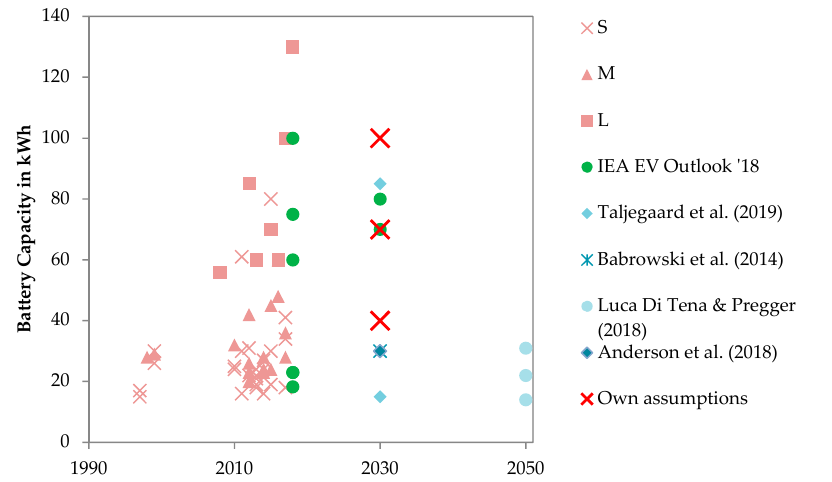
Figure A2. Historic development, prospective values from literature and own assumptions of BEV battery capacity values in kWh. Historic values are given in light red and differentiated between small (S), medium (M) and large (L) BEV models. Historic values are not weighted by sales or stocks. Ranges given in the IEA EV Outlook for 2018 as well as average fleet ranges for 2030 are given in green. Literature projections for 2030 and 2050 are given in light blue as indications. Own assumptions for the REMix model runs 0 and 1 are given as dark red crosses. Sources: Own composition based on [18,20,28,41,42].